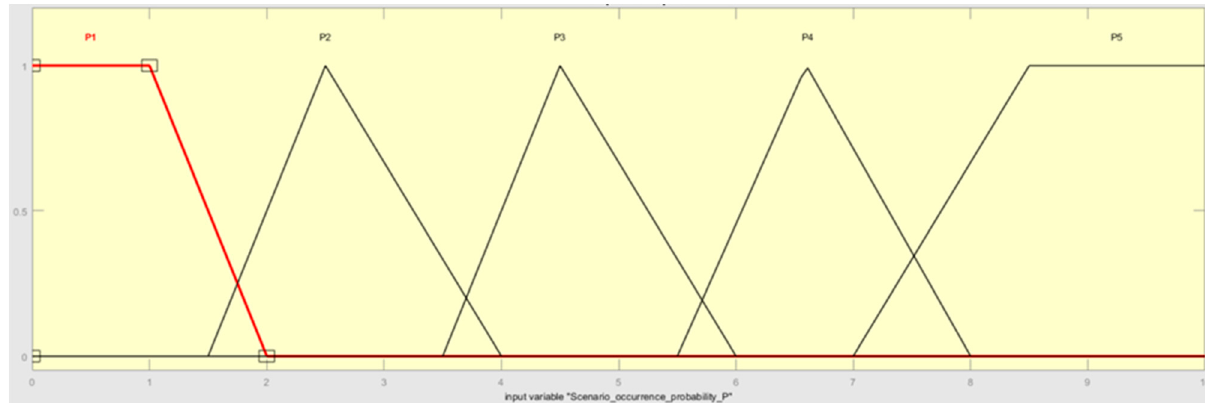
Figure 5. The structure of a typical fuzzy logic system (FLS) [39,48,57].